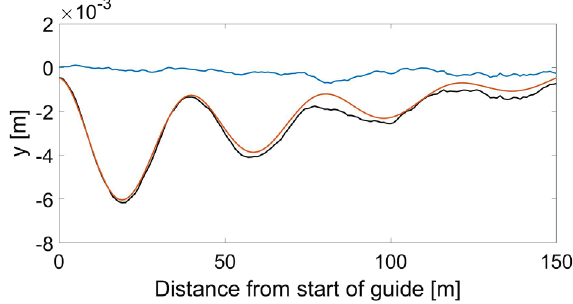
guide.FIG. 1. Model of the expected misalignment due to 6 mm maximal ground movement and random misalignment for a 150 m guide. The blue line is the accumulated random misalign- ment, dark orange is the systematic ground movement given in Eq. (4). The black line is the total displacement of the